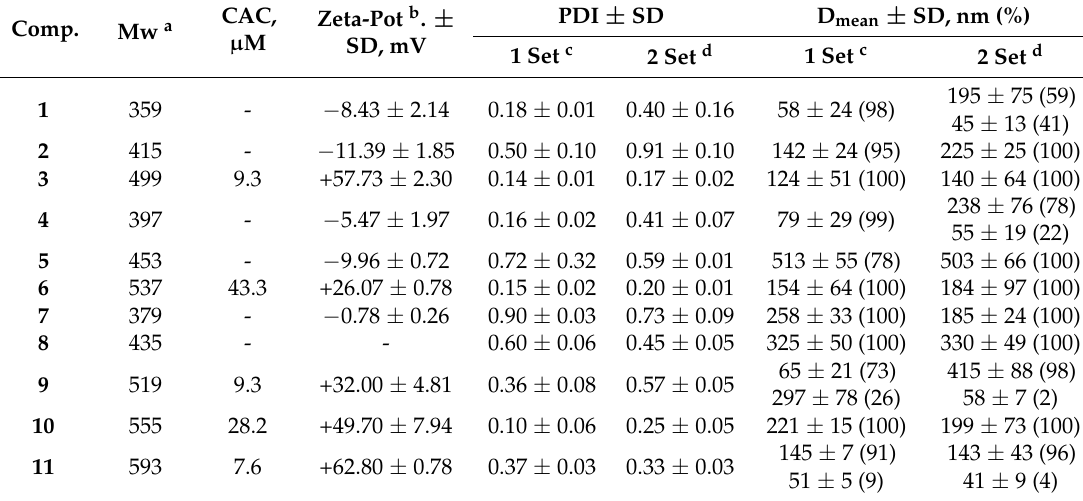
Table 2. Values of critical aggregation concentration (CAC), the mean diameter (D mean ), zeta-potential, and polydispersity index (PDI) of nanoparticles formed by 4-( N -alkylpyridinium)-1,4-DHP derivatives 1 – 11 obtained by dynamic light scattering (DLS) measurements. Final compound concentrations were 0.5 mg/mL for compounds 1 – 7 , 0.25 mg/mL for compounds 8 – 10 , and 0.1 mg/mL for compound 11 . The mean diameter (D mean ) depicts the hydrodynamic diameter of the main population of nanoparticles in the tested sample; the PDI value describes polydispersity of the sample; the zeta-potential gives information about the surface charge of nanoparticles. CAC is the concentration above which micelles and other nanoparticles are